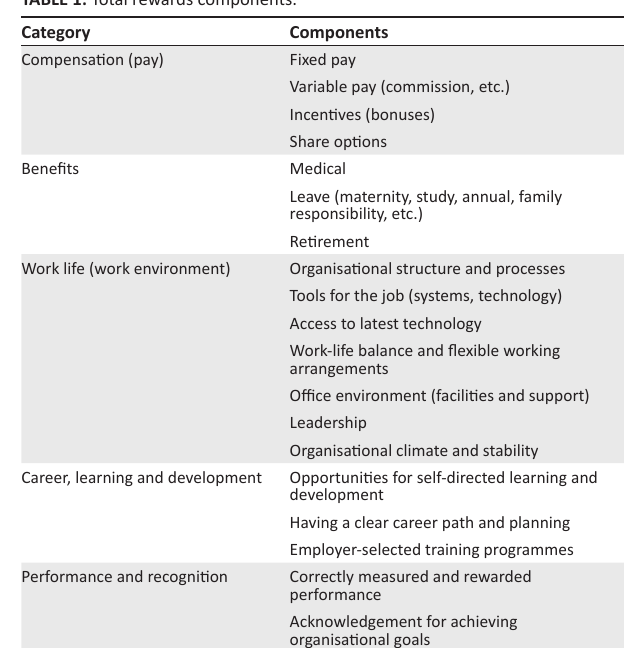
TABLE 1: Total rewards